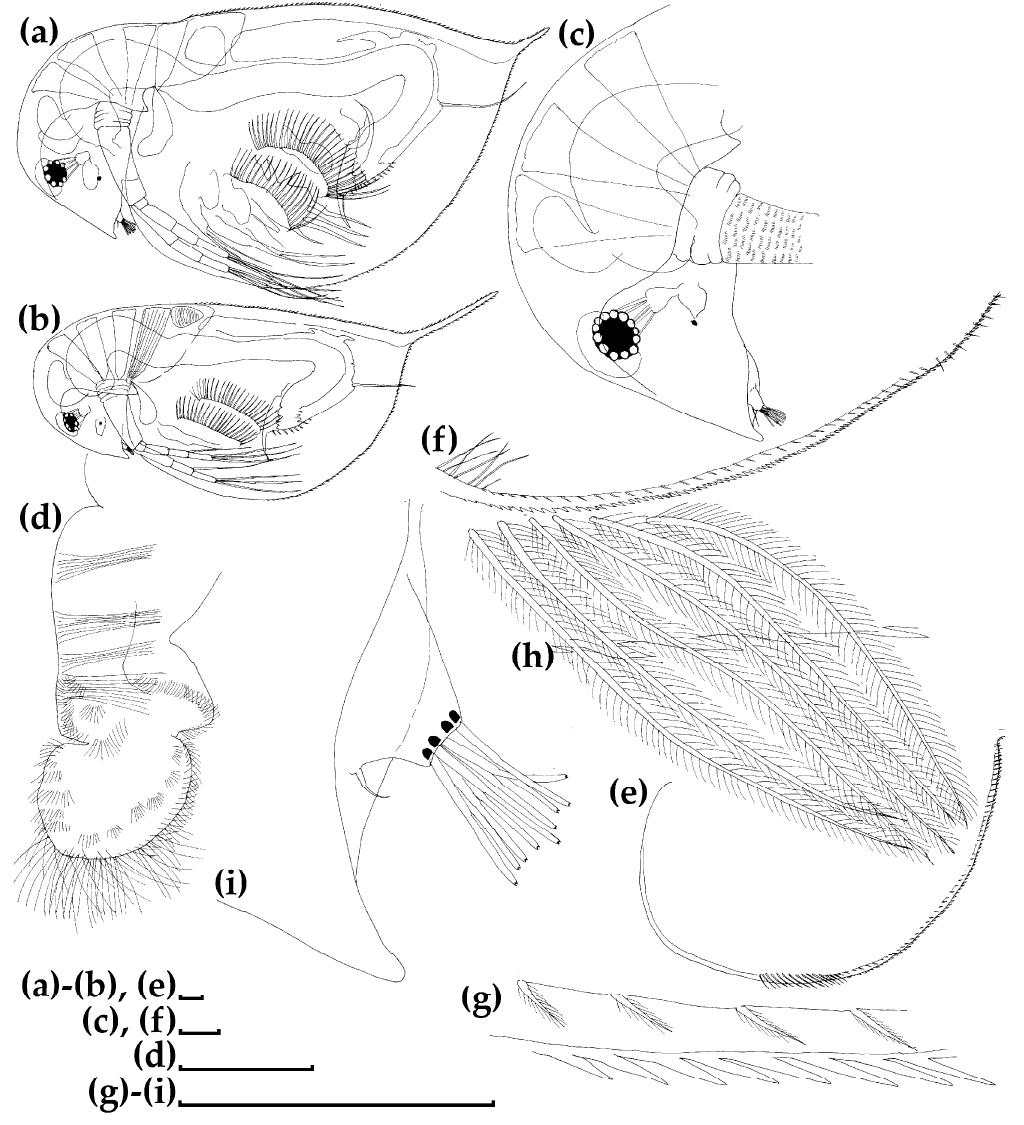
Figure 1. Daphnia arabica sp. nov., parthenogenetic females from Al Shuwaib Dam, near Al Ain city, United Arab Emirates, paratypes. ( a ) An adult female, lateral view. ( b ) A female of smaller size, lateral view. ( c ) Head. ( d ) Labrum. ( e ) Valve and its armature. ( f ) Armature of valve on higher magnification, inner view. ( g ) Armature of posterior portion of valve, inner view. ( h ) Armature of ventral portion of valve, inner view. ( i ), Rostrum and antenna I. All scale bars are 0.1